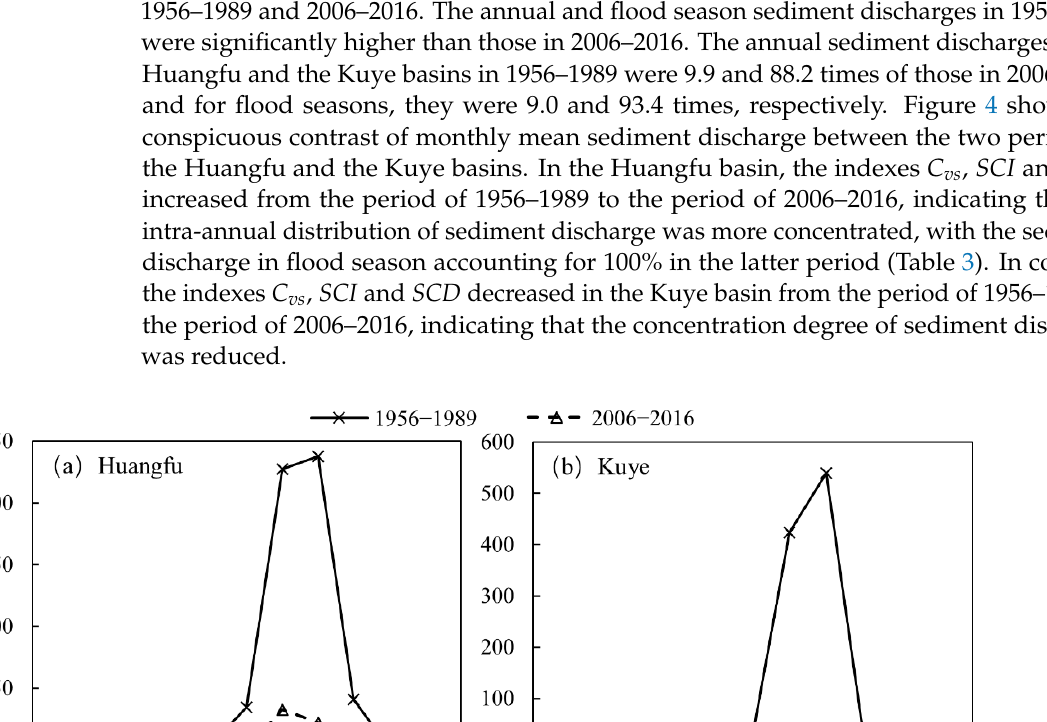
Table 3. Average values of sediment indexes in two periods.